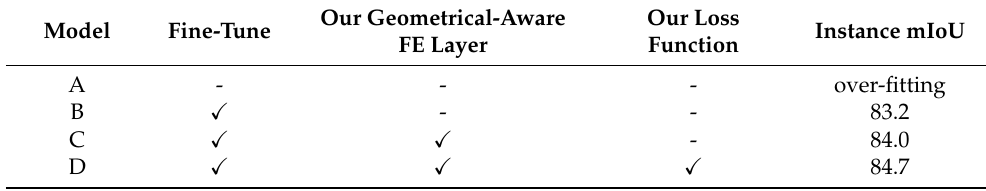
Table 7. Ablation studies on the proposed 3D component segmentation dataset (%).